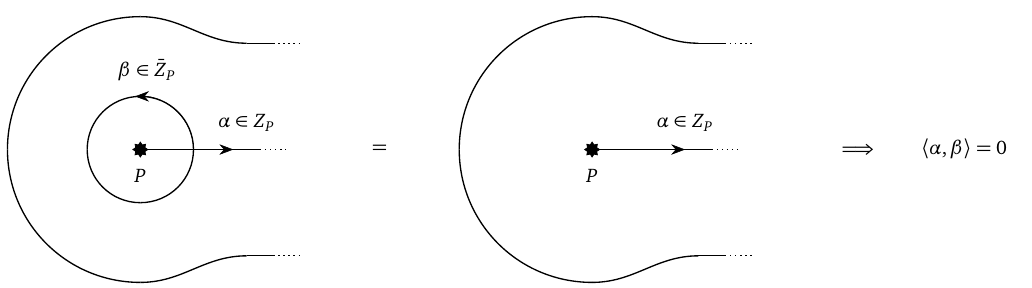
Figure 11: A consistent pairing on L exists only if the mutual pairing between ele- ments of ¯ Z and Z P P